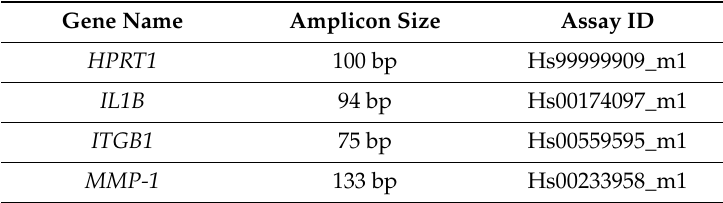
Table 2. Primers used for RTD PCR in the present study (purchased via ABI,